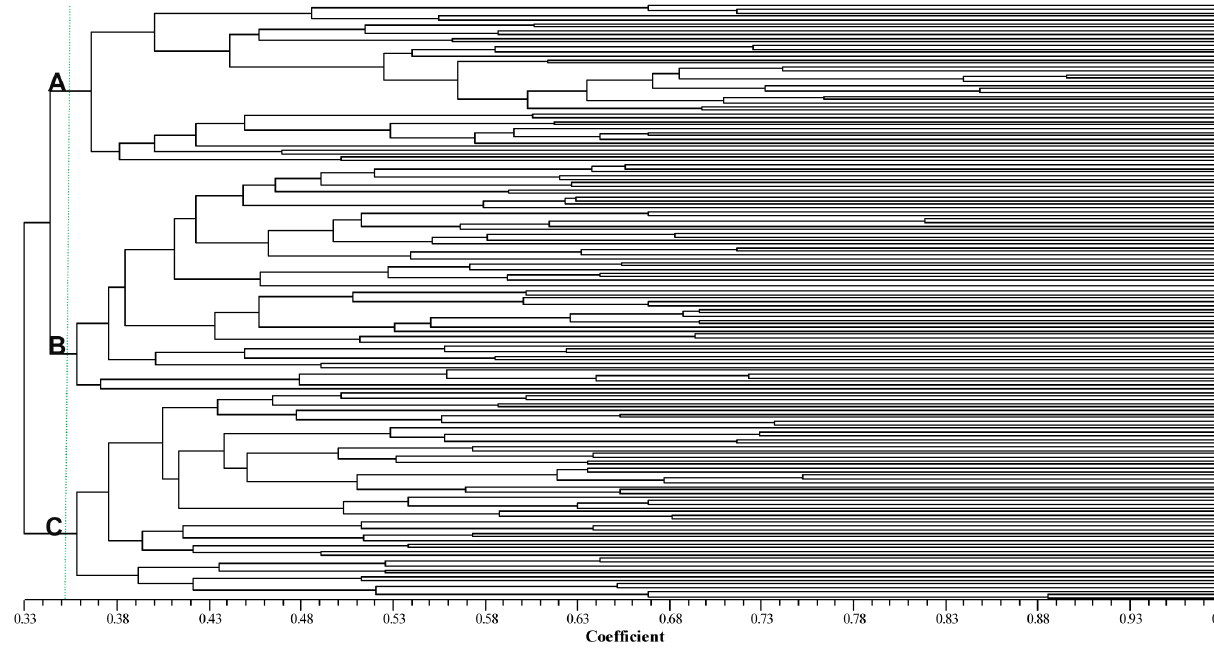
Figure 2. Dendrogram for 165 maize accessions based on a cluster analysis of genetic similarities from SSR data.